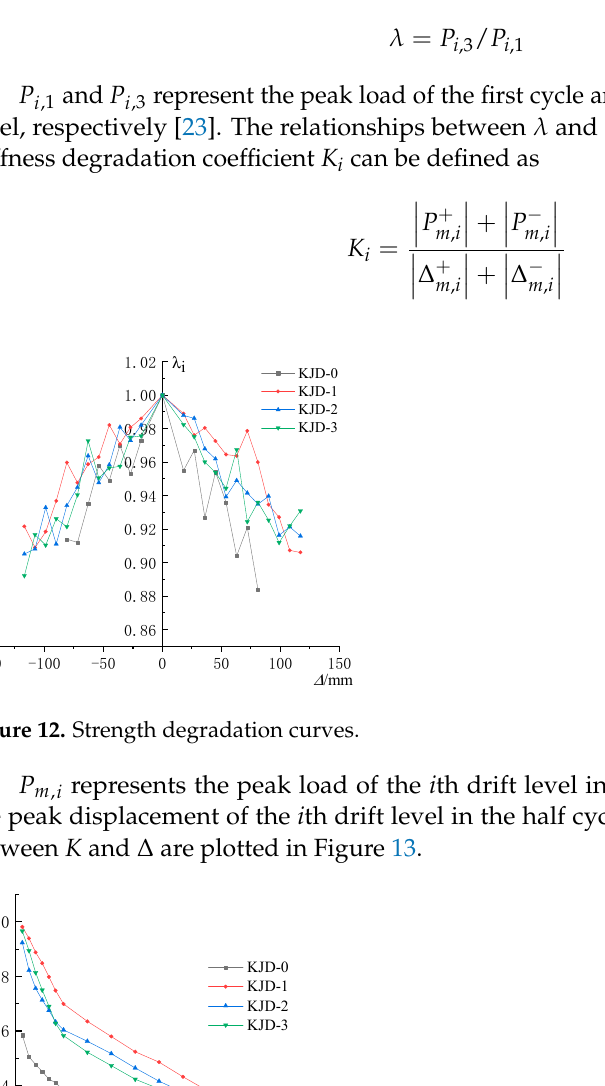
Figure 13. Stiffness degradation curves.